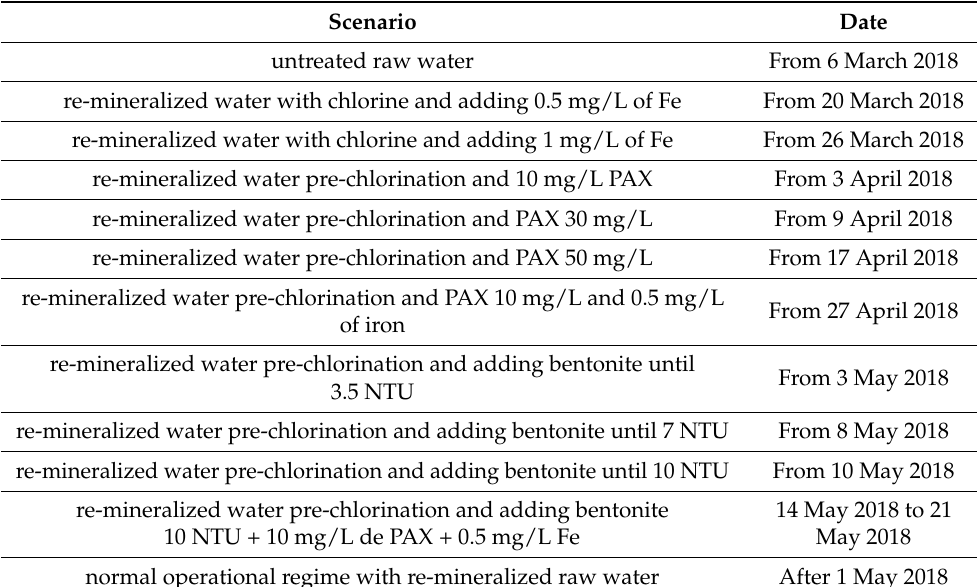
Table 1. Different scenarios of the operations and